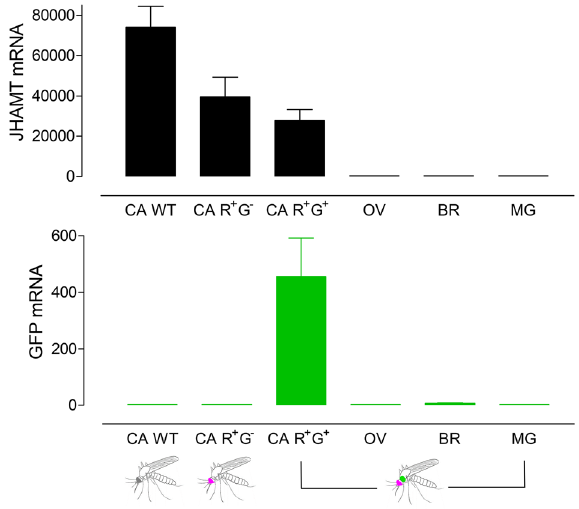
Figure 2. Tissue-specific expression of jhamt and eGFP . Real-time qPCR measurement of jhamt and eGFP mRNA levels in tissues of 3–5 days old sugar-fed WT and jhamt eGFP + /− adult female exhibiting either eGFP + or eGFP − CA. CA WT: corpora allata wild-type; CA R + G − : heterozygote with red eyes and CA not green; CA R + G + : heterozygote with red eyes and green CA; OV ovaries, BR brain, MG midgut (all tissues dissected from insects with green CA). Levels of mRNAs are expressed as copy numbers per 10,000 copies of RpL32 mRNA. Each data point is an average of 3 independent biological replicates of tissues from 5 to 10 insects.